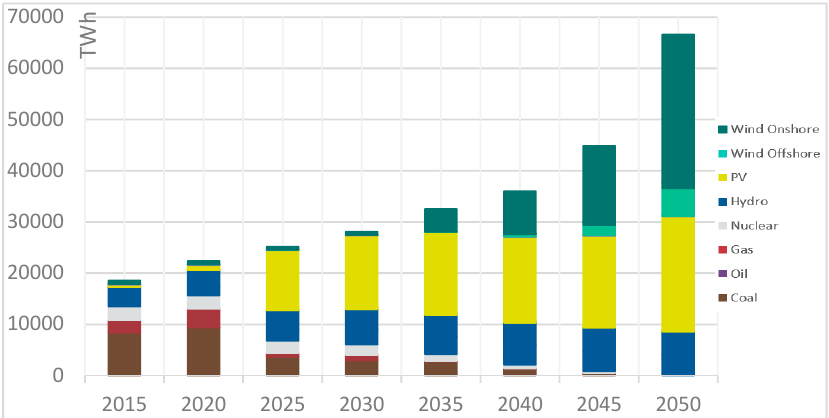
Figure 5. Development of global power generation.